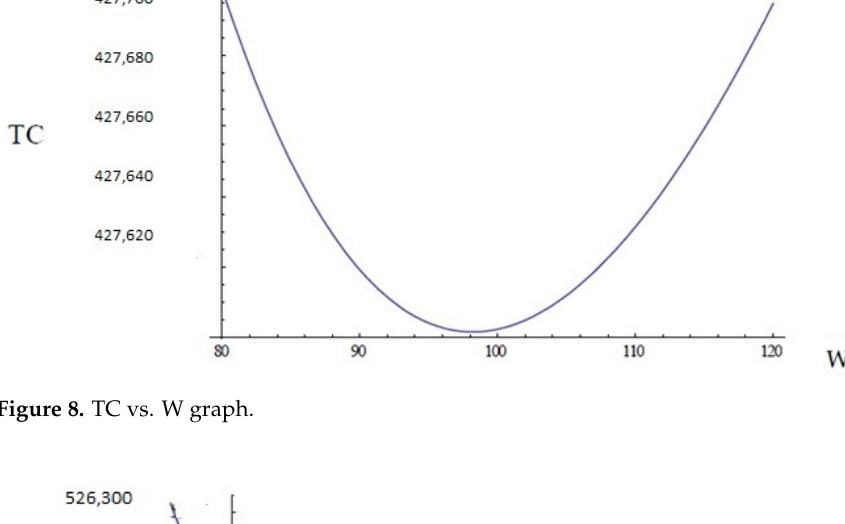
Figure 8. TC vs. W graph.